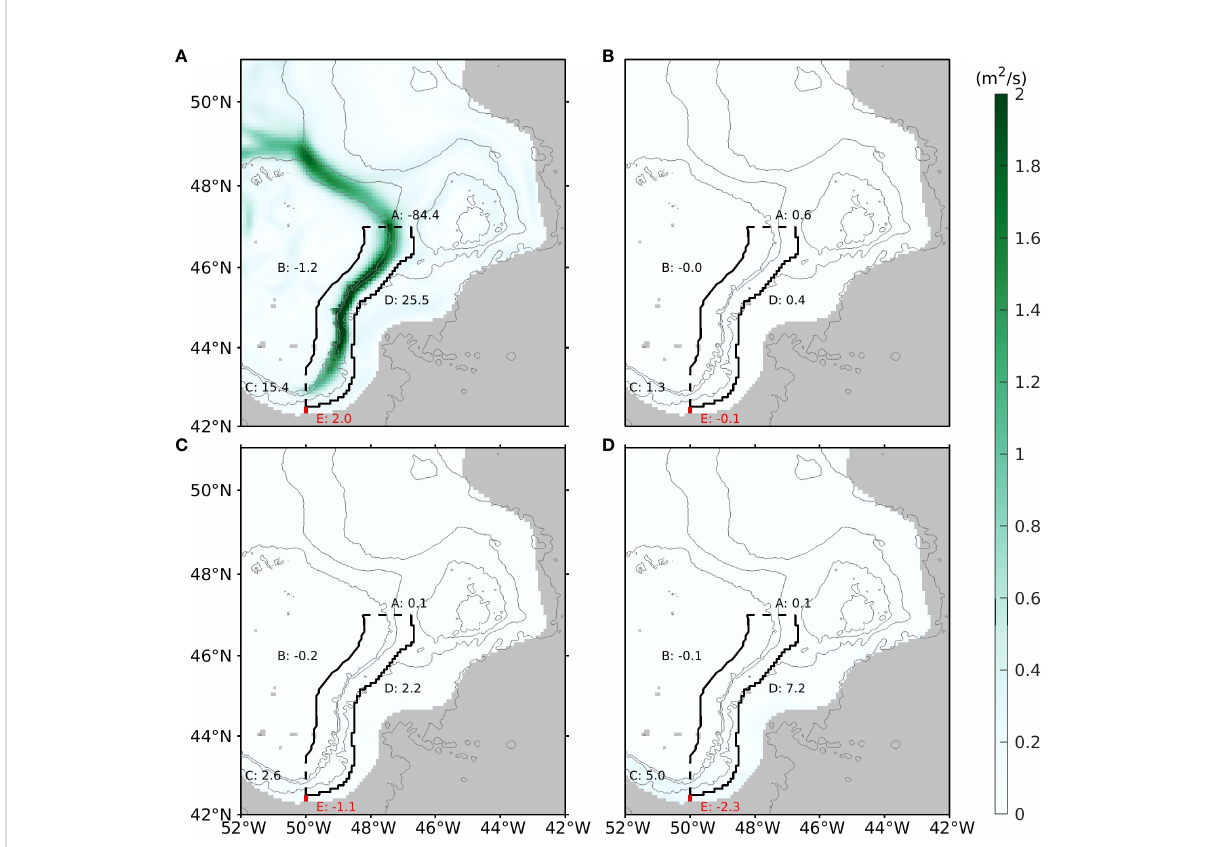
(cid:1) ~ F by the (A) mean advection, (B) seasonal variation, (C) inter-annual variation, and (D) intra-